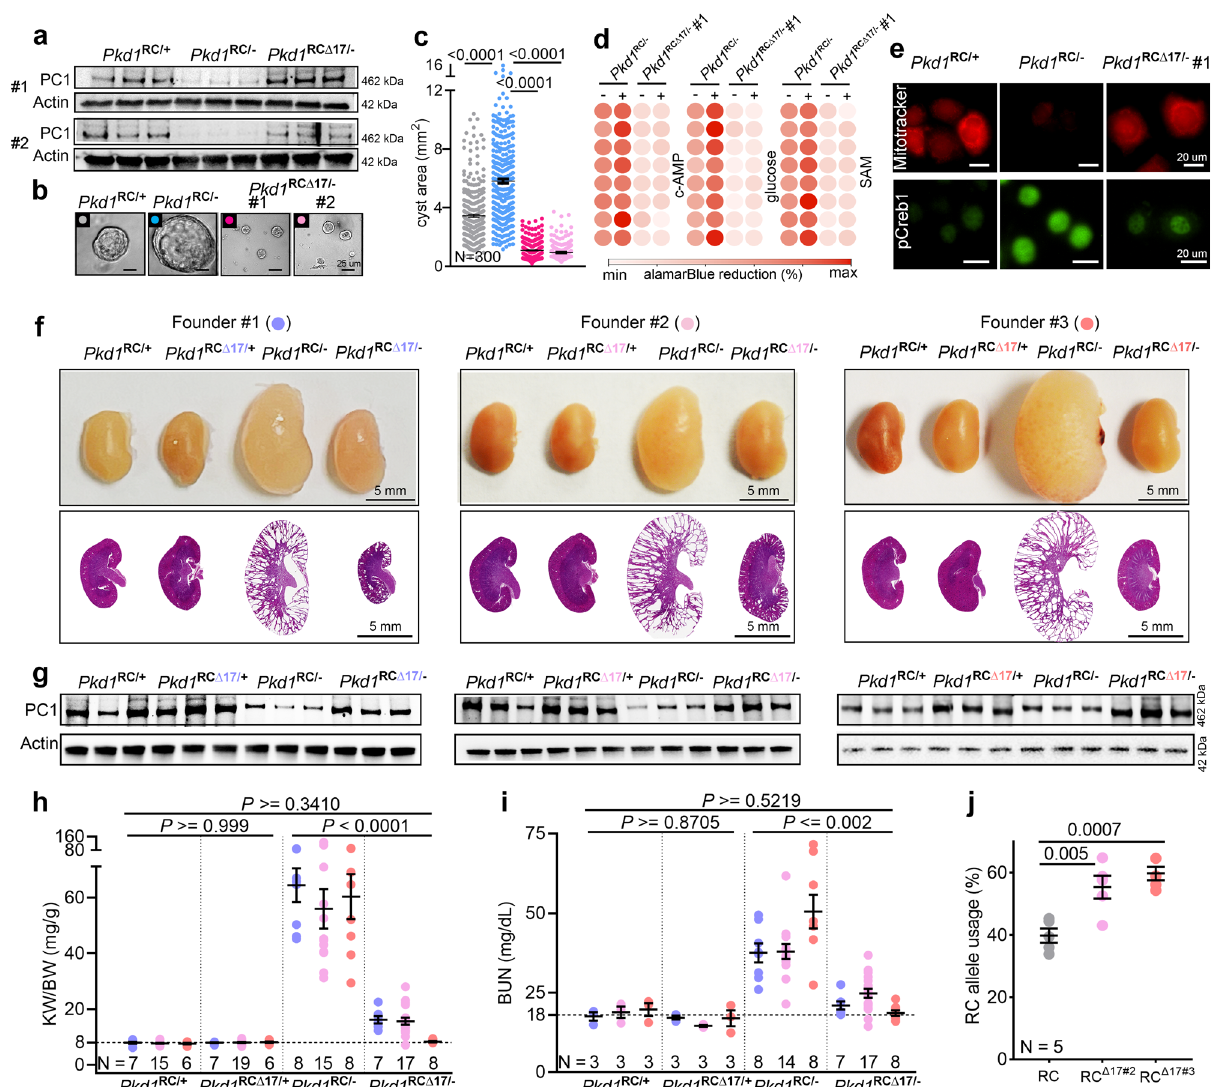
Fig. 2 | Monoallelic Pkd1 derepression alleviates polycystic kidney disease. a Immunoblot showing reduced PC1 expression in Pkd1 RC/- compared to Pkd1 RC/+ cells. PC1 level was restored in Pkd1 RC Δ 17/- cells. #1 and #2 refer to the two inde- pendent Pkd1 RC Δ 17/- clonal cell lines. Actin serves as the loading control. n =3 bio- logically independent samples. b – c Representative images and quanti fi cation showing increased 3D cyst size of Pkd1 RC/- compared to Pkd1 RC/+ cells cultured in Matrigel. Cyst size was normalized in Pkd1 RC Δ 17/- cells. n =300 cysts pooled from three independent experiments. d Heatmap showing alamarBlue-assessed pro- liferationof Pkd1 RC/- and Pkd1 RC Δ 17/- cellsintheabsence( − )orpresence(+)of100uM cAMP, 17mM glucose, or 100 uM SAM. n =8, each circle represents a biological replicate. e Representative images showing Mito-tracker labeling and anti-pCreb1 immunostaining in Pkd1 RC/+ , Pkd1 RC/- , and Pkd1 RC Δ 17/- cells. n =3 biologically depen- dentexperiments. f Grosskidneyand H&E-stained kidneysectionsfrom 18-day-old micewiththeindicatedgenotypes.Datafromtheprogenyofthethreefoundersare